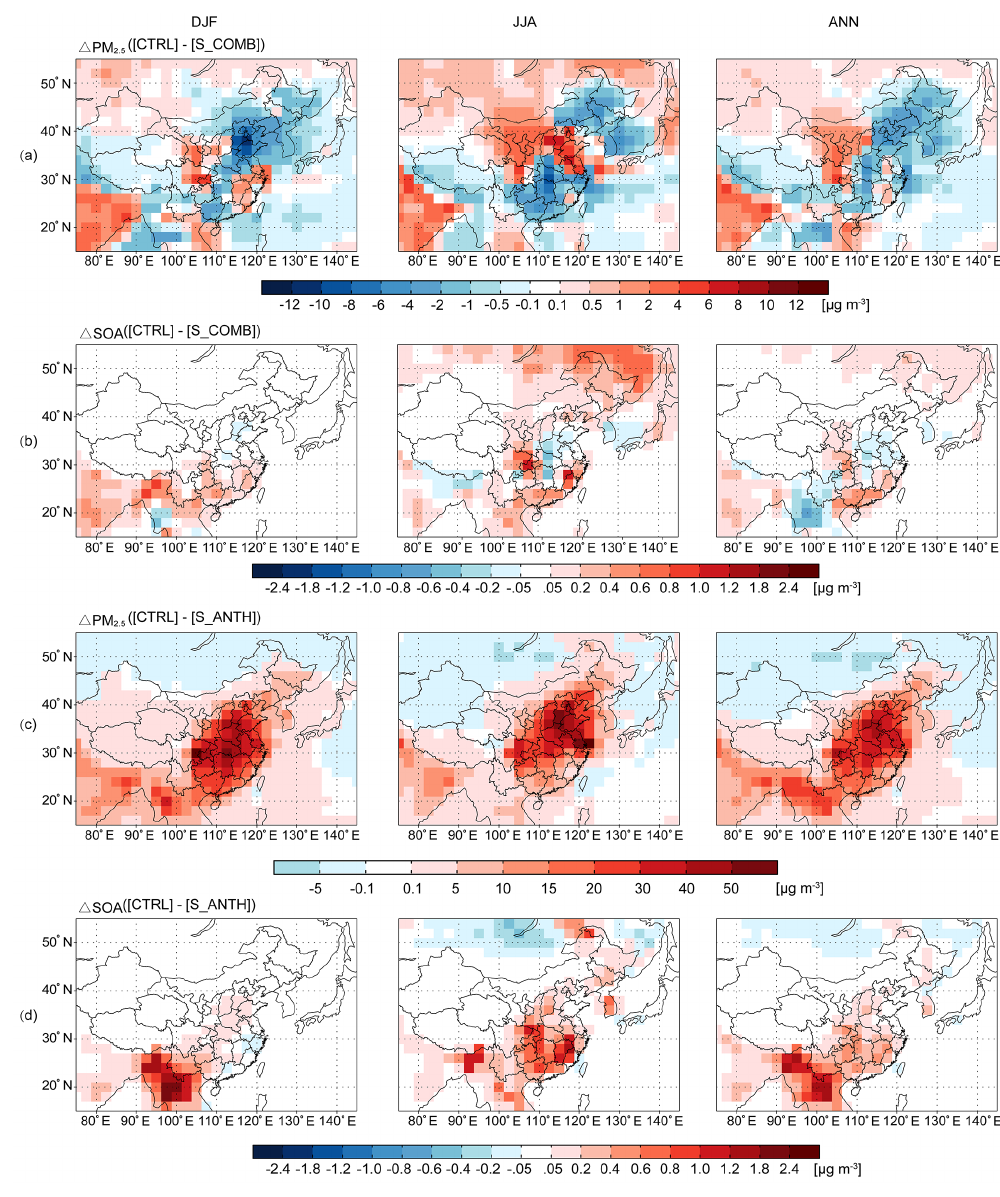
Figure 9. Changes in seasonal (DJF and JJA) and annual (ANN) mean surface concentrations of PM 2 . 5 and SOA in East Asia resulting from the combined effects of 1980–2010 changes in climate, land cover and land use ([ CTRL ] – [ S_COMB ]), and 1980–2010 changes in anthropogenic emissions alone ([ CTRL ] – [ S_ANTH